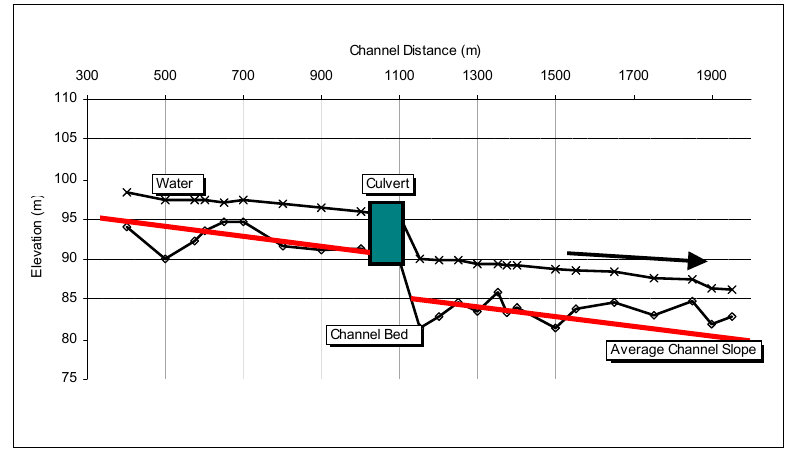
Figure 6. Example longitudinal profile with channel bed off-set depicting systemic downstream incision.